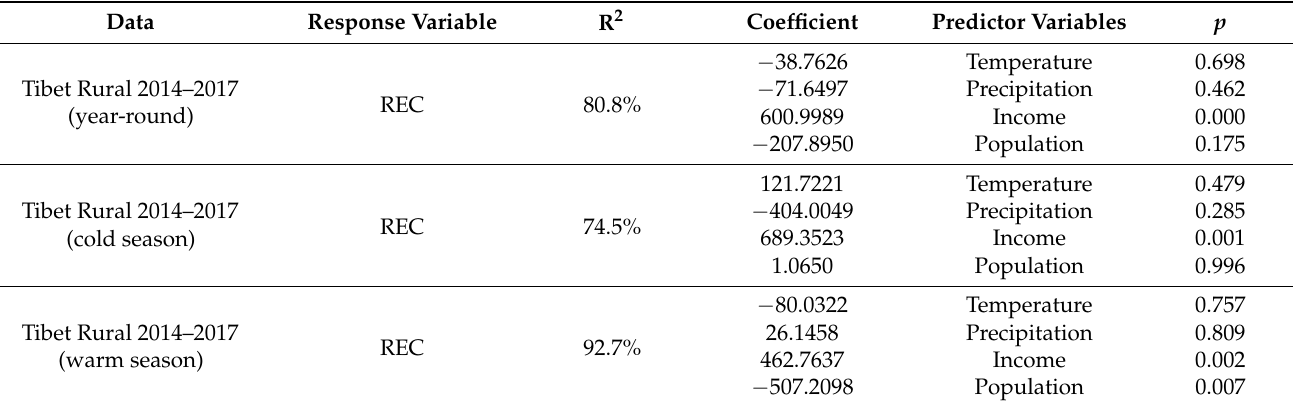
Table 2. Results of the rural model for